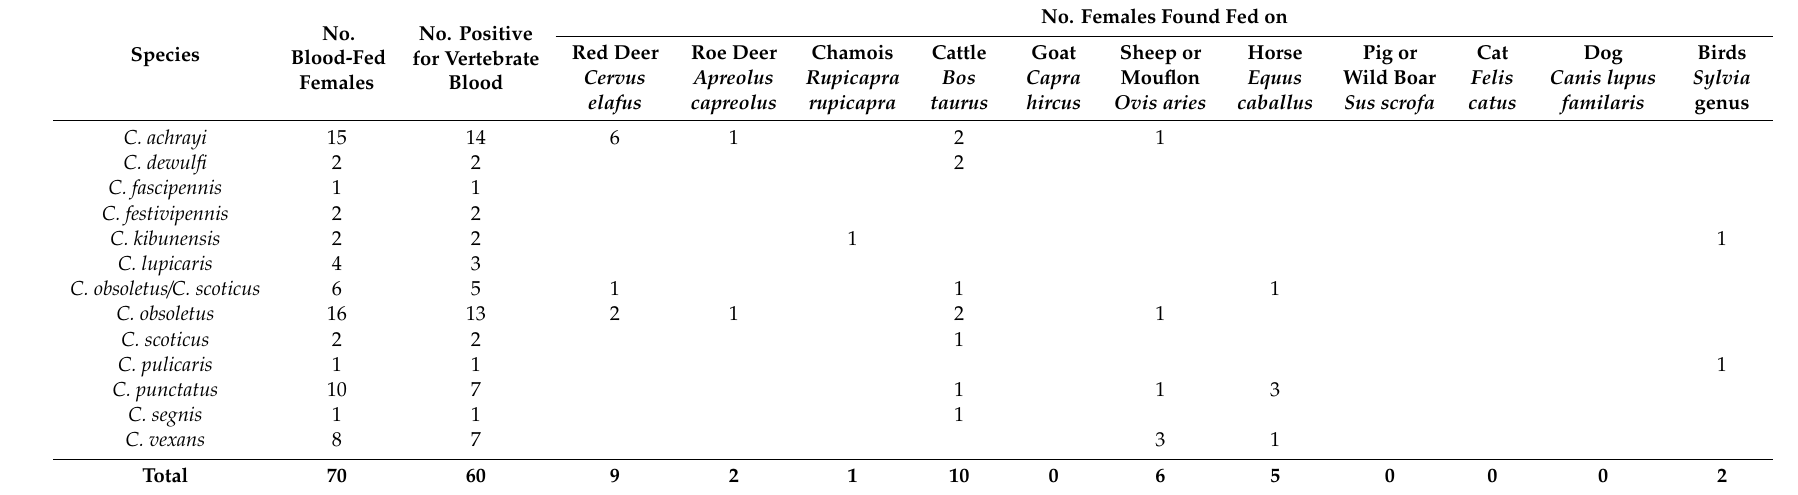
Table 6. Identification of the blood-meal origin of the blood-fed females collected in wildlife zones (June to August 2008) using UV-light suction traps (OVI model) in five di ff erent ecological and climatic French